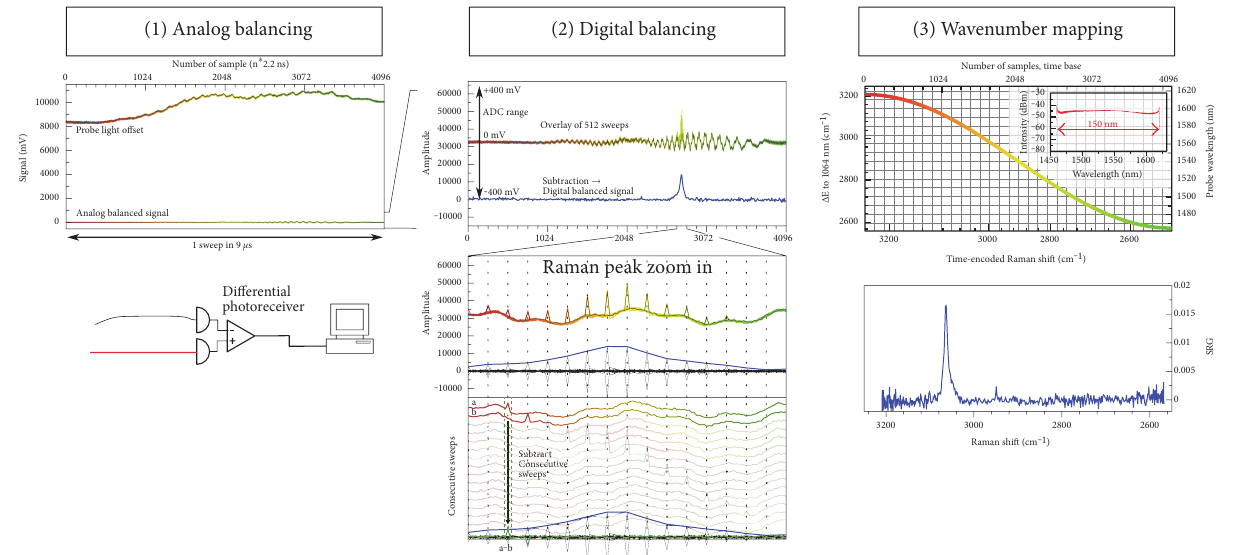
Figure 2: Raman spectra extraction by two-stage balanced detection, leading to an SRG spectrum of benzene. Left: The fi rst analog balancing step employs a balanced, di ff erentially ampli fi ed photoreceiver to remove the probe light o ff set. Only power changes in the sample arm remain (cf. Figure 1). Middle: The analog-to-digital converter (ADC) card is used to synchronously sample the FDML probe laser sweeps. The 800mV range is sampled at 12-bit depth resolution. The lower part shows a zoom-in on a part where SRG signals occur. The vertical lines represent the positions of the pump pulses following the TICO-Raman excitation technique [17]. The SRG signals are clearly visible and fully recorded as ensured by the synchronized detection (see text). The second digital balancing step subtracts consecutive sweeps to further lower the noise level to the shot-noise limit. Only pump-induced intensity changes remain. This step makes use of TICO-Raman pattern, where pulse positions increase from sweep to sweep. Thus, through subtraction, any artifacts due to chromatic imperfections are removed. Right: The last step assigns wavenumber values to the Raman spectrum. First, the spectrum of the FDML laser (inset) is recorded on an optical spectrum analyzer (OSA). Then, the wavelength-to-time mapping of the FDML laser is calculated and from that the energy di ff erence to the pump laser is determined. The result is accurate Raman shift energies for each spectral point. Shown in blue is the fi nal shot-noise limited TICO-Raman spectrum of benzene, acquired in 9